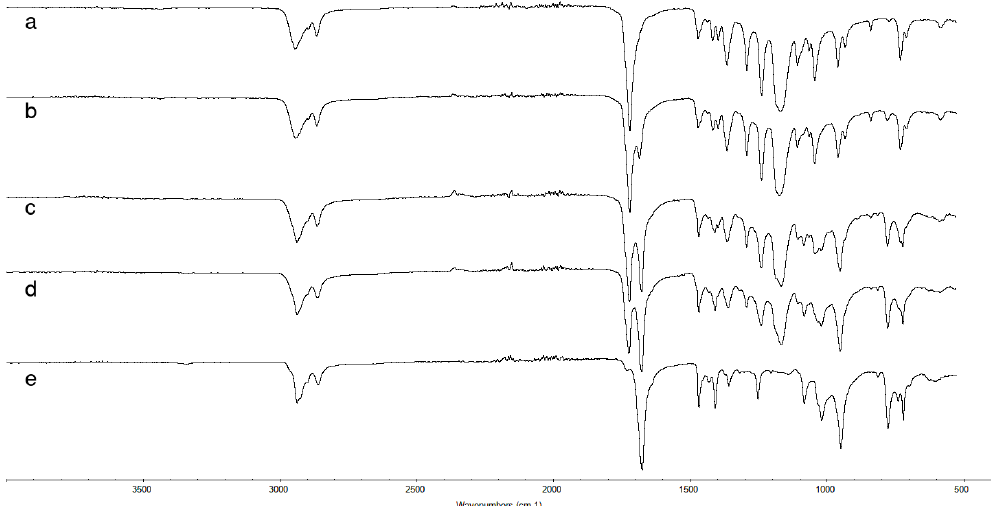
Figure 1. Fourier transform infrared (FTIR) spectra of ( a ) poly( ε -caprolactone) (PCL), ( e ) poly( ε -thiocaprolactone) (PTCL), and poly( ε -caprolactone-co- ε -thiocaprolactone) COP copolymers with molar proportions of ( b ) 2:1, ( c ) 1:1, and ( d ) 1:2.